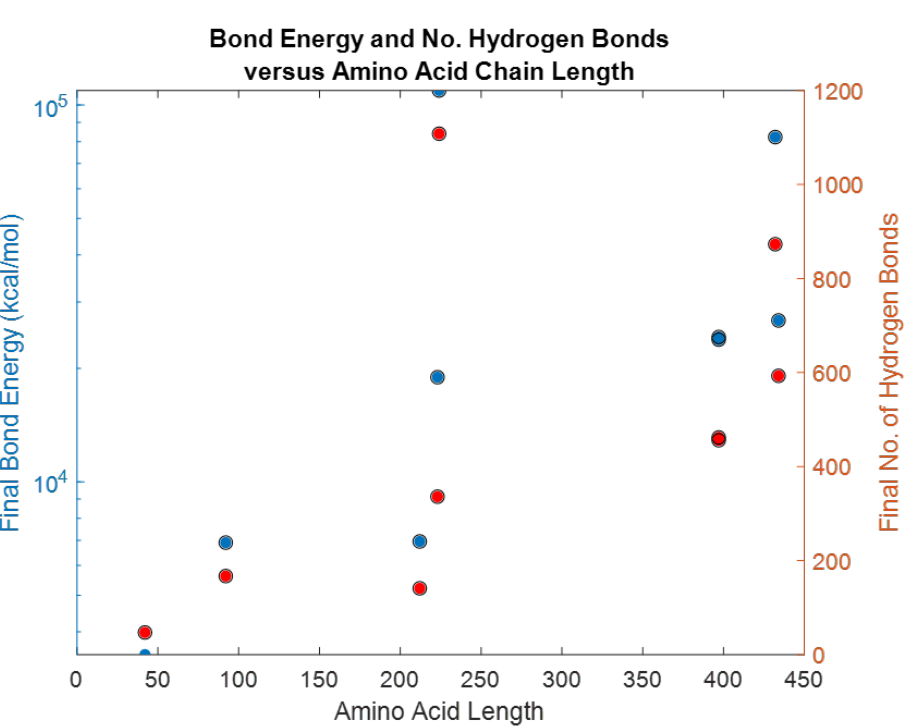
Figure 34. Relationship of number of bonds and bond energy with the amino acid length for the biomarkers.